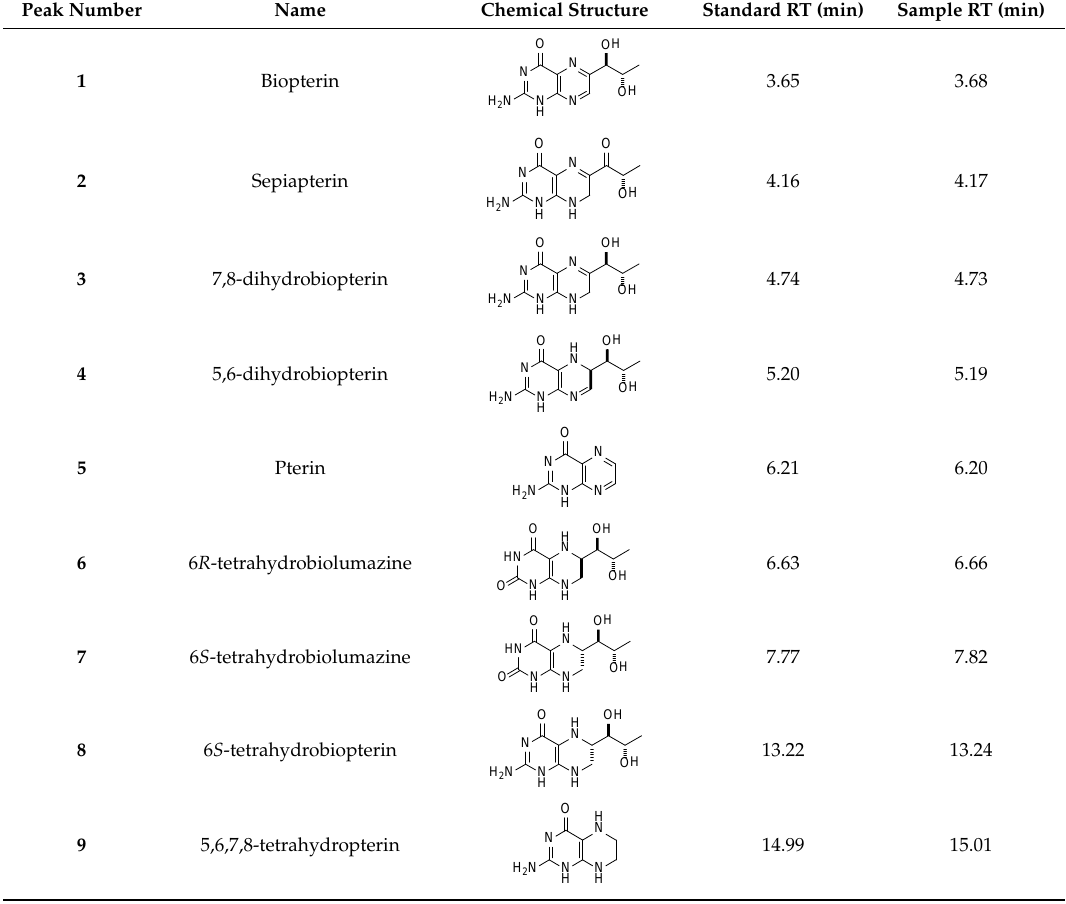
Table 1. Assignment of minor compounds detected for Kuvan ® tablet at T = 0.